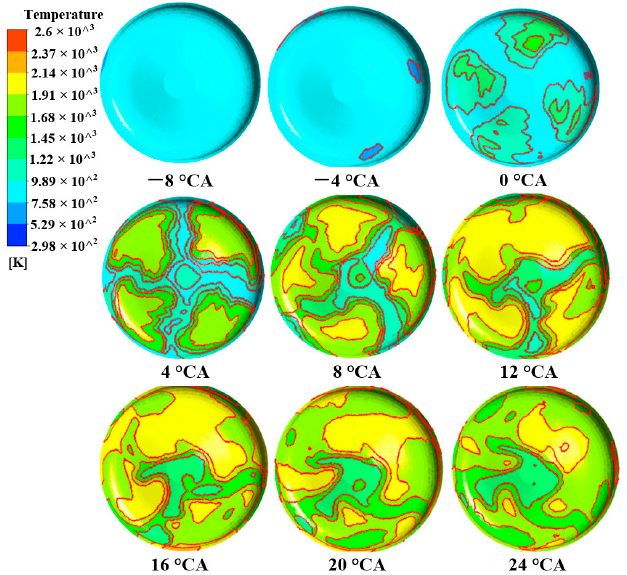
Figure 10. Distribution of Temperature Field in Cylinder at Different Times.